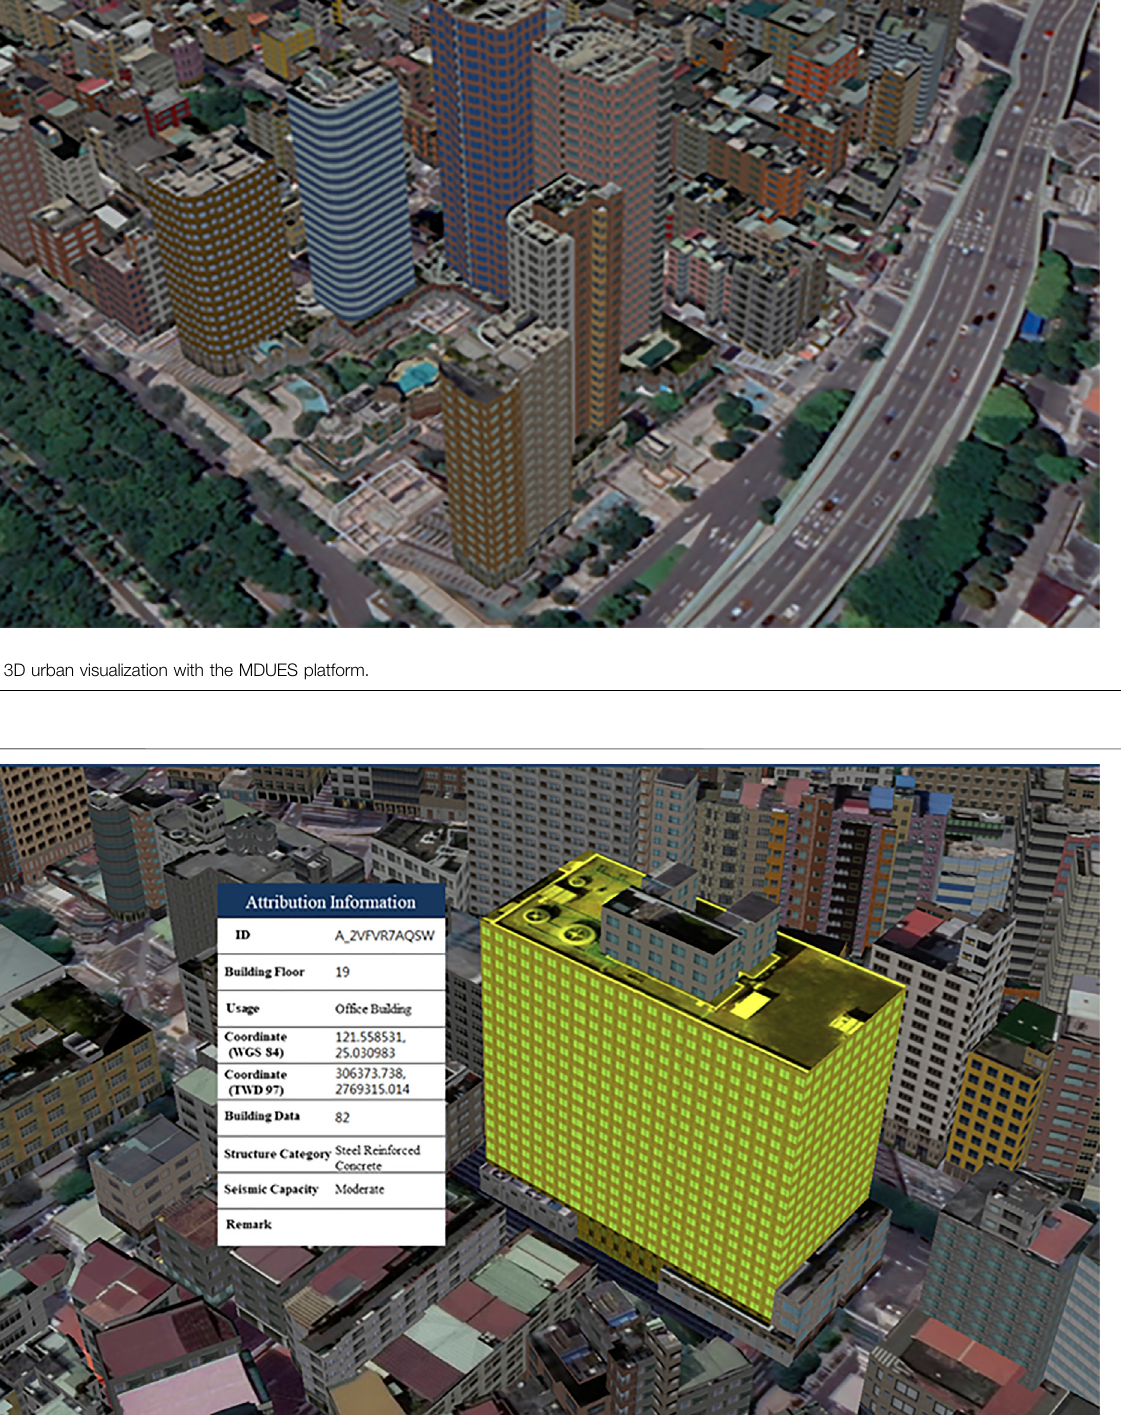
Frontiers in Built Environment |